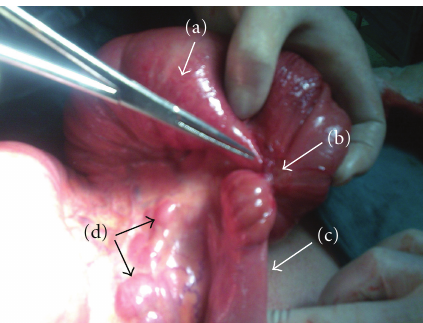
Figure 3: Endometriotic glands within lymph node (HE, × 100).